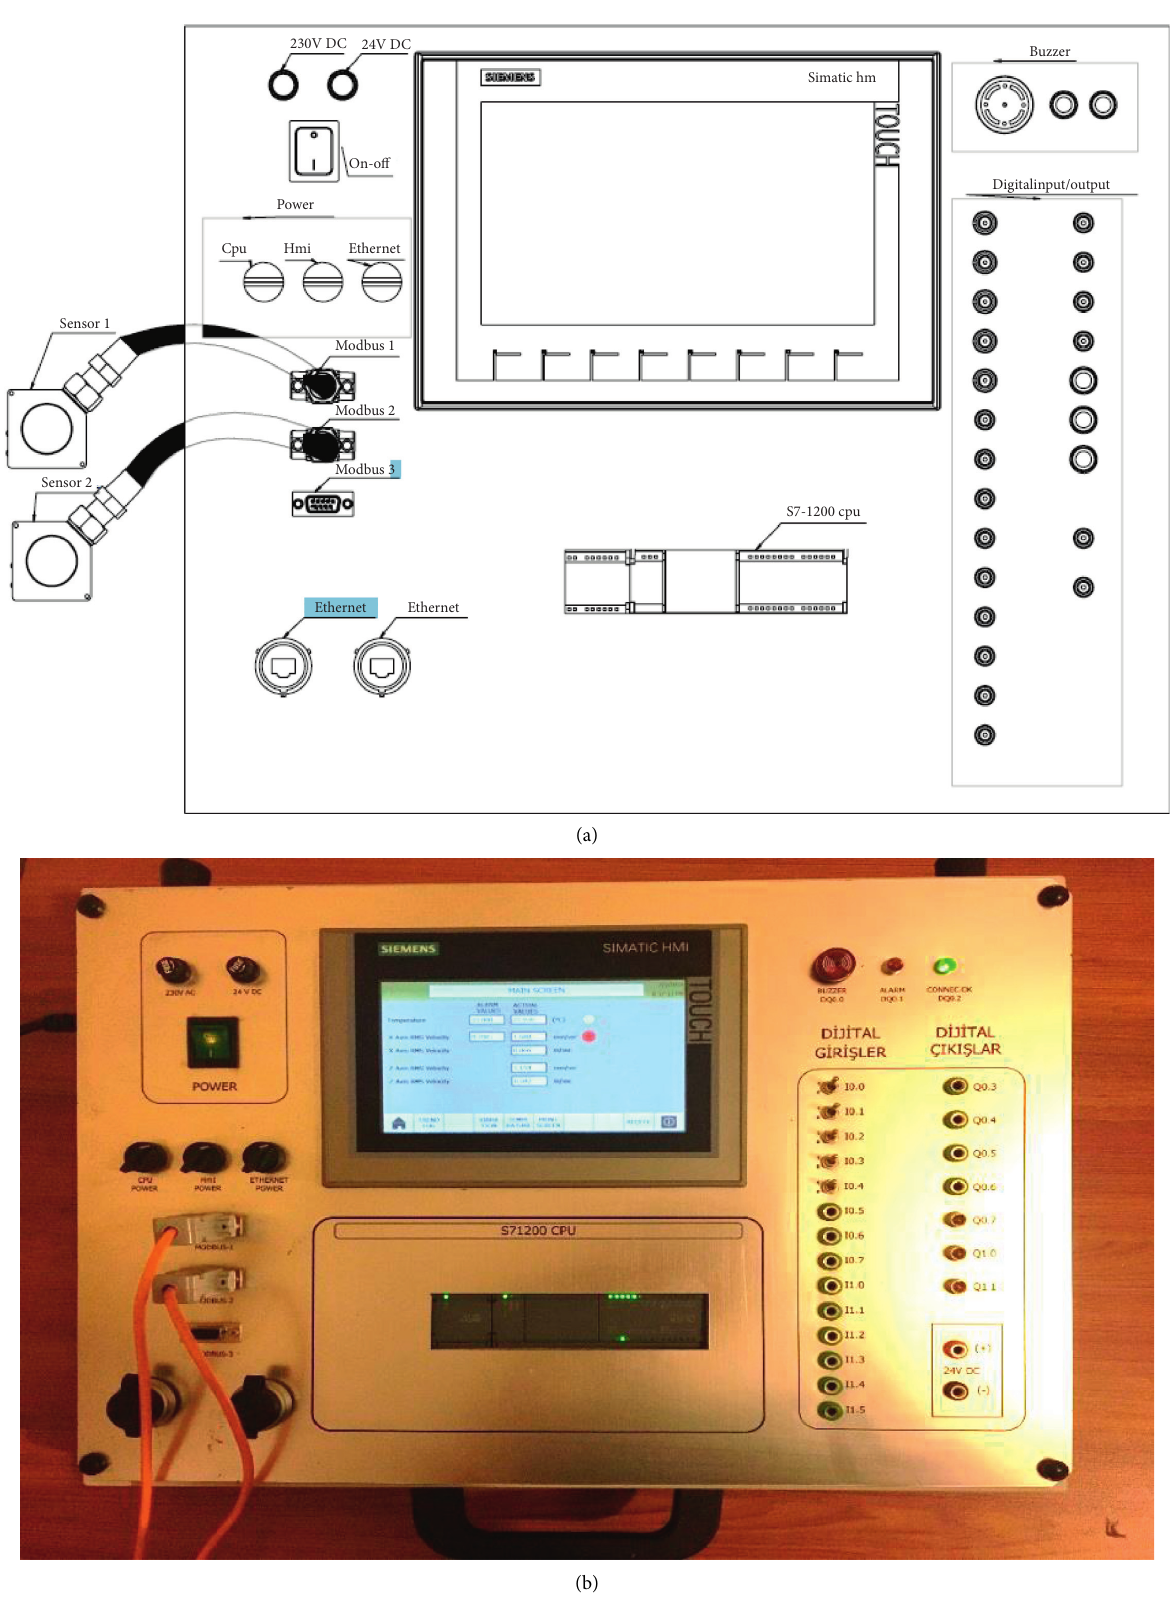
Figure 4: (a) Design of the vibration and temperature measurement set and its appearance at the moment of energization ((b)